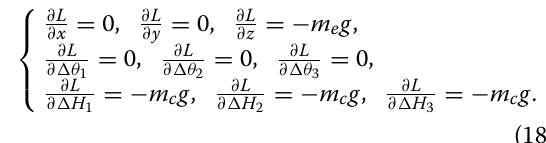
The dynamics model of the UCPR can be obtained by